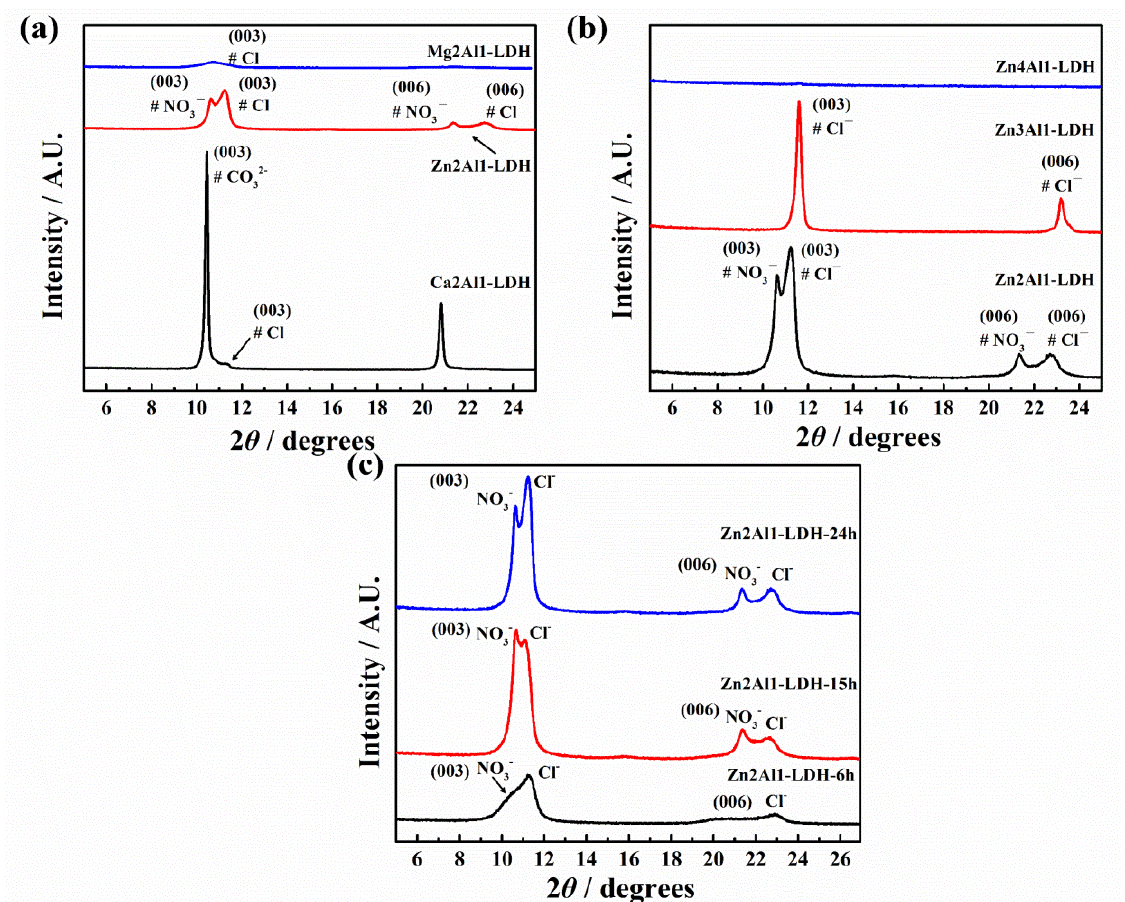
Figure 7. The XRD spectrum of different samples after immersion in 0.02 mol/L NaCl solution for 40 h ( a ) Ca2Al1-LDH, Zn2Al1-LDH and Mg2Al1-LDH; ( b ) Zn2Al1-LDH, Zn3Al1-LDH and Zn4Al1-LDH; ( c ) Zn2Al1-LDH-6h, Zn2Al1-LDH-15h and Zn2Al1-LDH-24h.